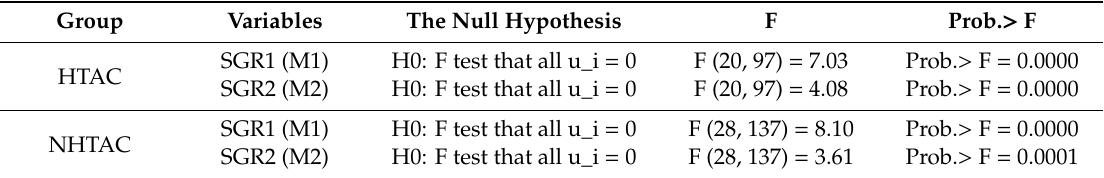
Table 4. F test of models.